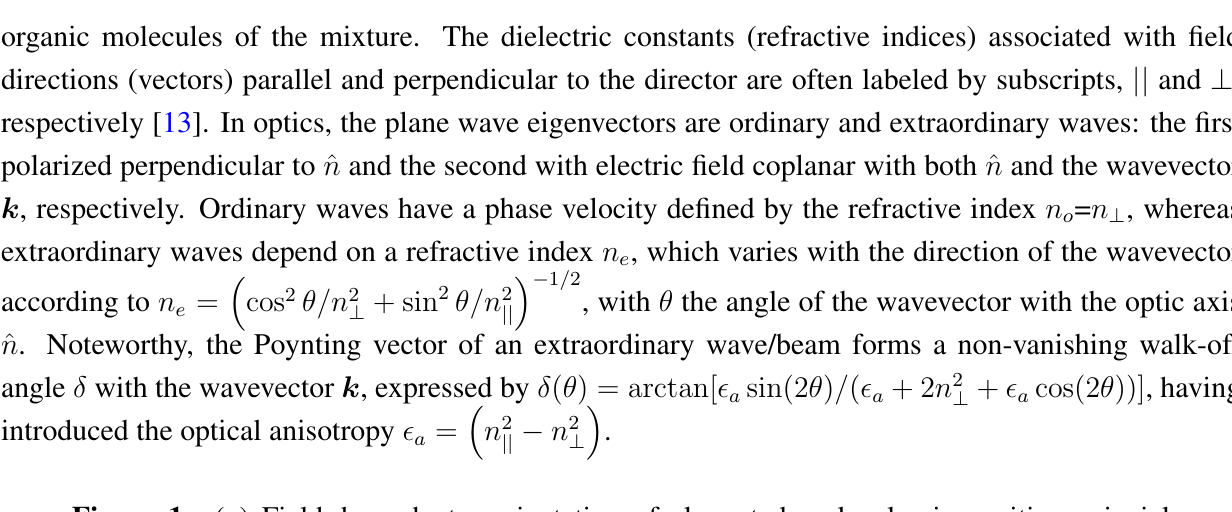
Figure 1. ( a ) Field-dependent reorientation of elongated molecules in positive uniaxial versus angle θ between nematic liquid crystals (NLC); ( b ) Extraordinary refractive index n e ˆ n and k with reference to the commercial NLC mixture E7; ( c ) Diffraction of a weak light beam in NLC (power is low enough that no appreciable reorientation takes place); ( d ) Intense light beam undergoing self-confinement. compensates diffraction, and a nematicon is generated. The highly nonlocal response results in an index profile (blue line labeled n ) much wider than the solitary beam (red line labeled A ), owing to the intermolecular elastic forces. In panels ( c , d ), we ignored the walk-off